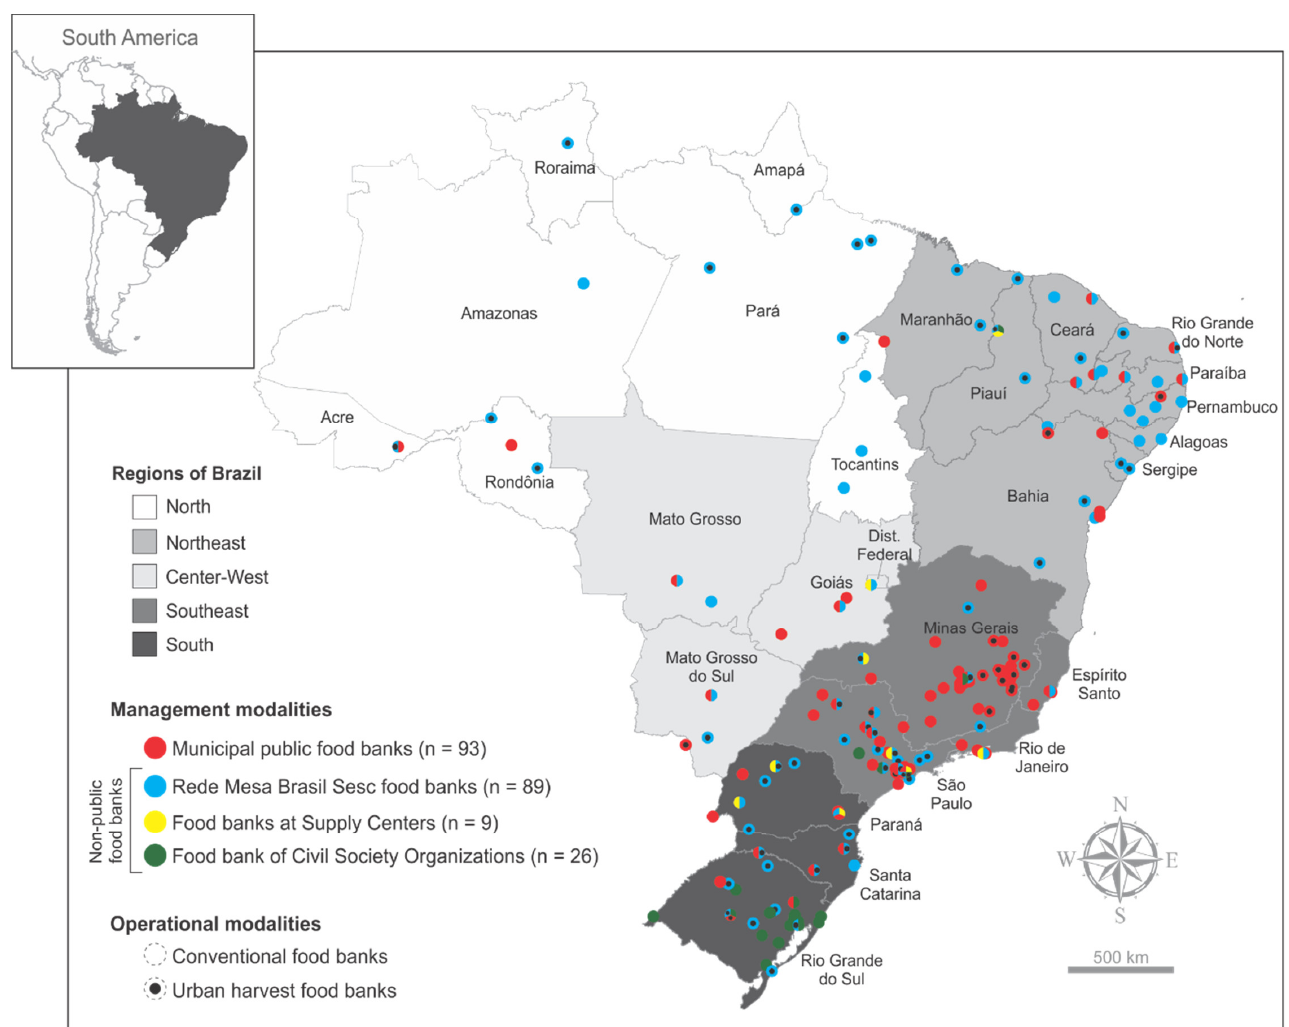
Figure 2. Distribution of all the food banks operating in Brazil in 2019, according to their management and operational modalities ( n = 217).